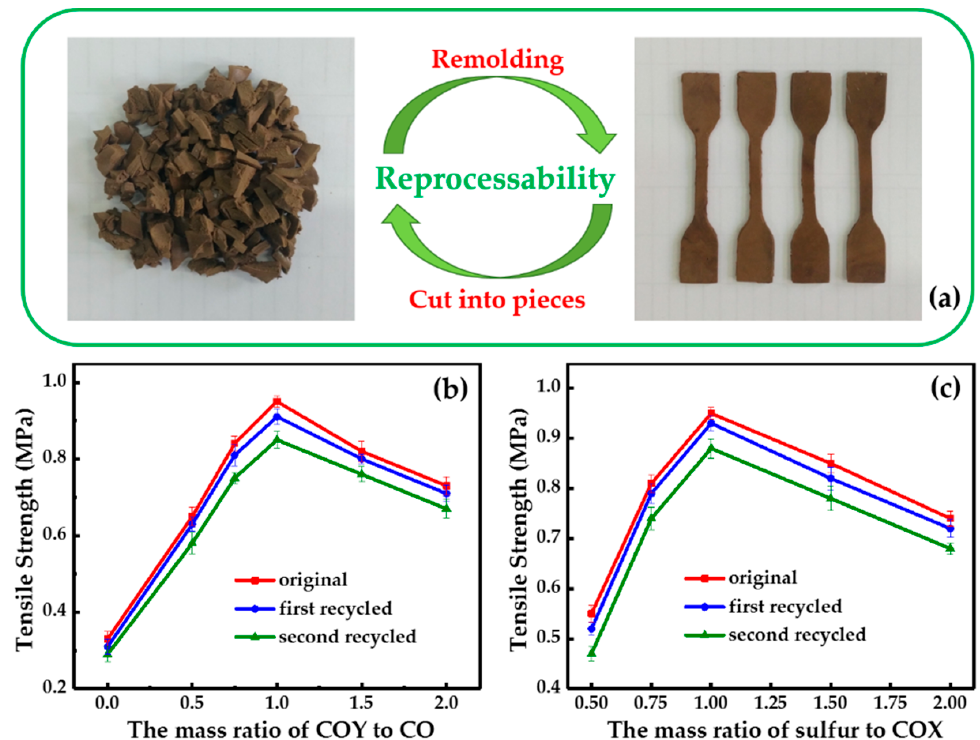
Figure 6. Reprocessability and recyclability of SCO / COS serial samples. ( a ) Digital photos of thermal reprocessing ability of SCO / COS serial samples; ( b ) tensile strength variation in SCO / COS serial samples versus the mass ratio of COY to CO after multiple reprocesses; ( c ) tensile strength variation in SCO / COS serial samples versus the mass ratio of sulfur to COX after multiple reprocesses.